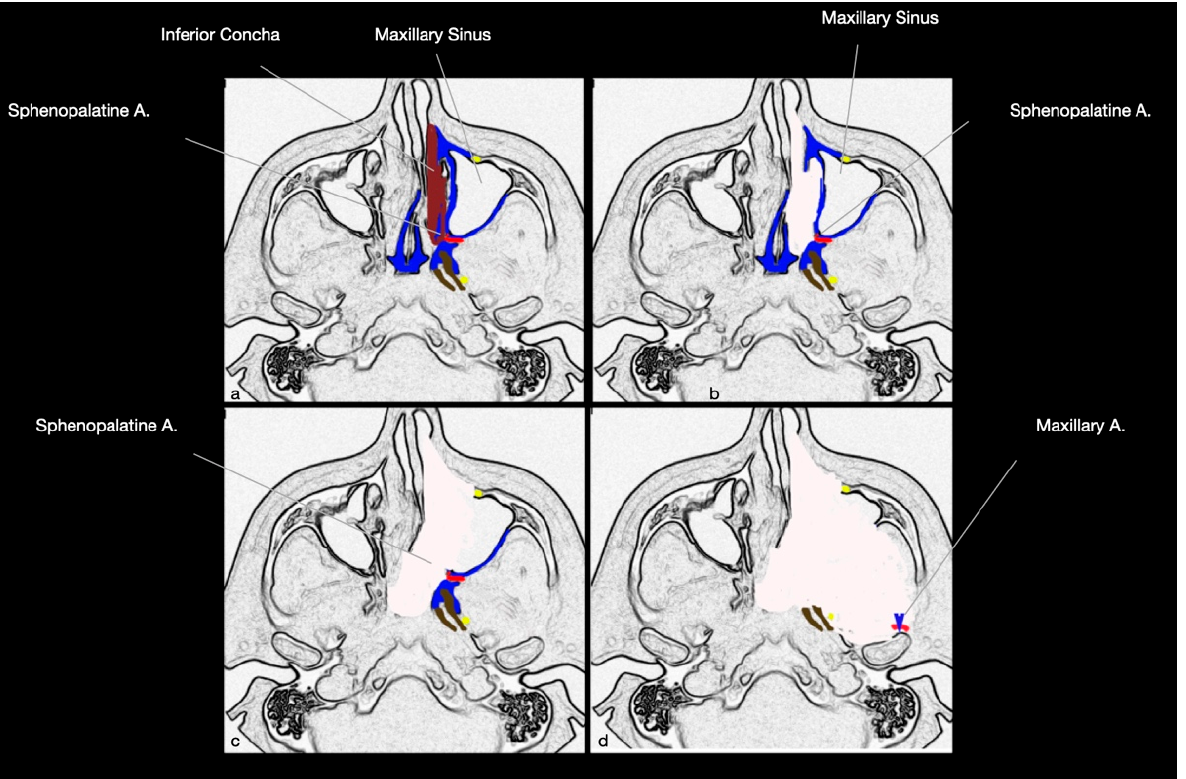
Figure 1. Schematic representation of the different surgical steps for endoscopic transmaxillary- pterygoid approach for ITF and PPF tumors. The anatomical relationship between the posterior wall of maxillary sinus and these fossae is at the base of such approach. ( a ) The inferior nasal concha is completely or partially resected. ( b ) The ostium of maxillary sinus (semilunar hiatus) can be identified. ( c ) An antero-medial maxillectomy, with ipsilateral spheno-ethmoidotomy is performed to expose the posterior wall of maxillary sinus. Sphenopalatine artery is coagulated or litigated after its exposure in the sphenopalatine foramen. ( d ) The posterior wall of maxillary sinus is resected as largely as needed, depending on tumor extension. Maxillary artery is usually clipped to avoid intra- or peri-operative bleedings. (A: Artery).